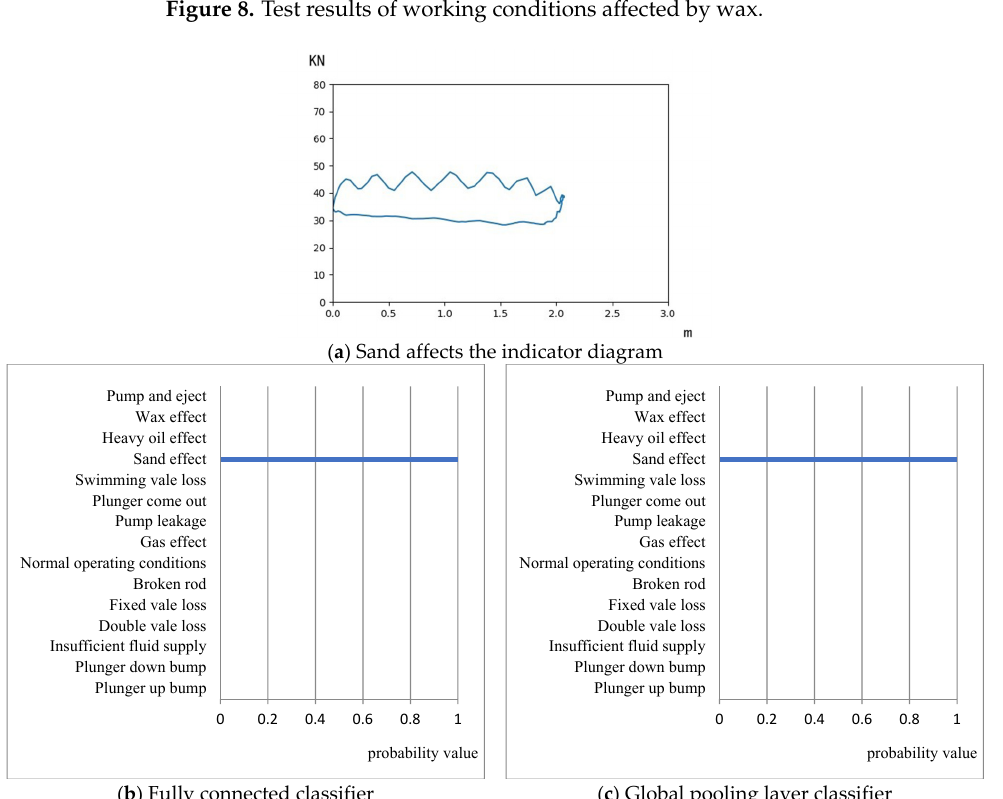
Figure 8. Test results of working conditions affected by wax.